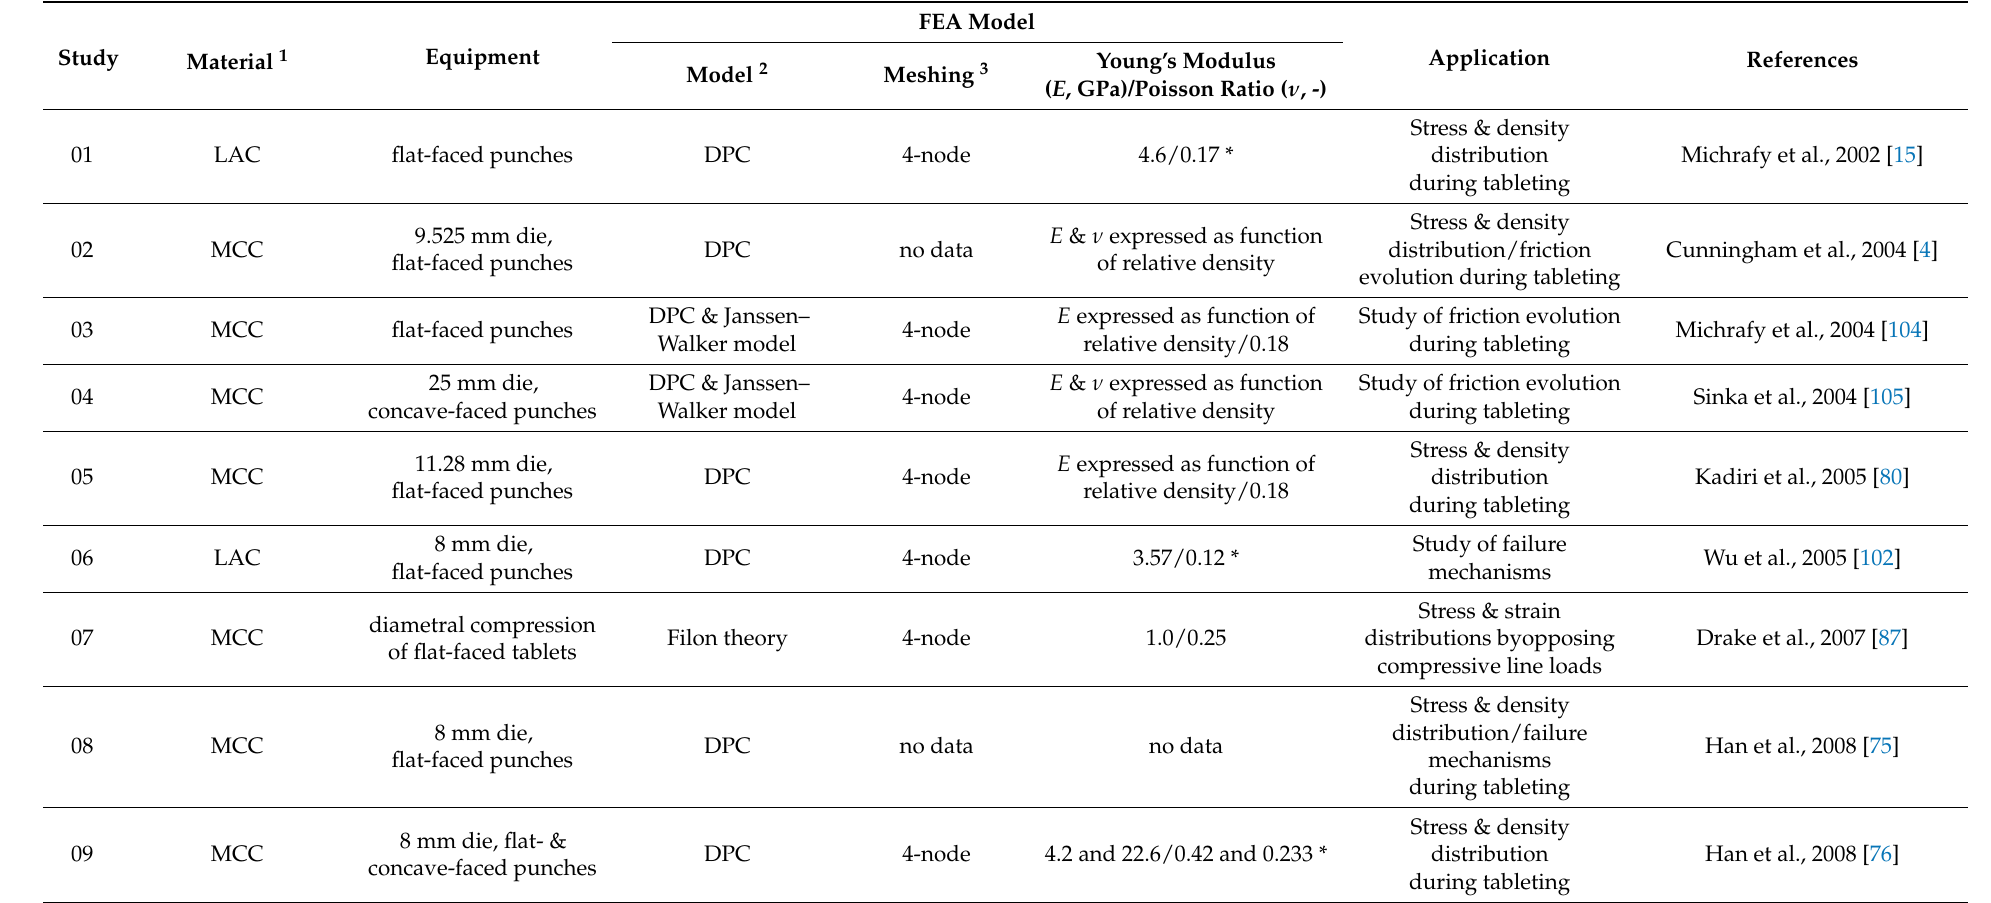
Table 1. Studies on the application of finite element analysis (FEA) in the tableting and mechanical strength test of pharmaceutical